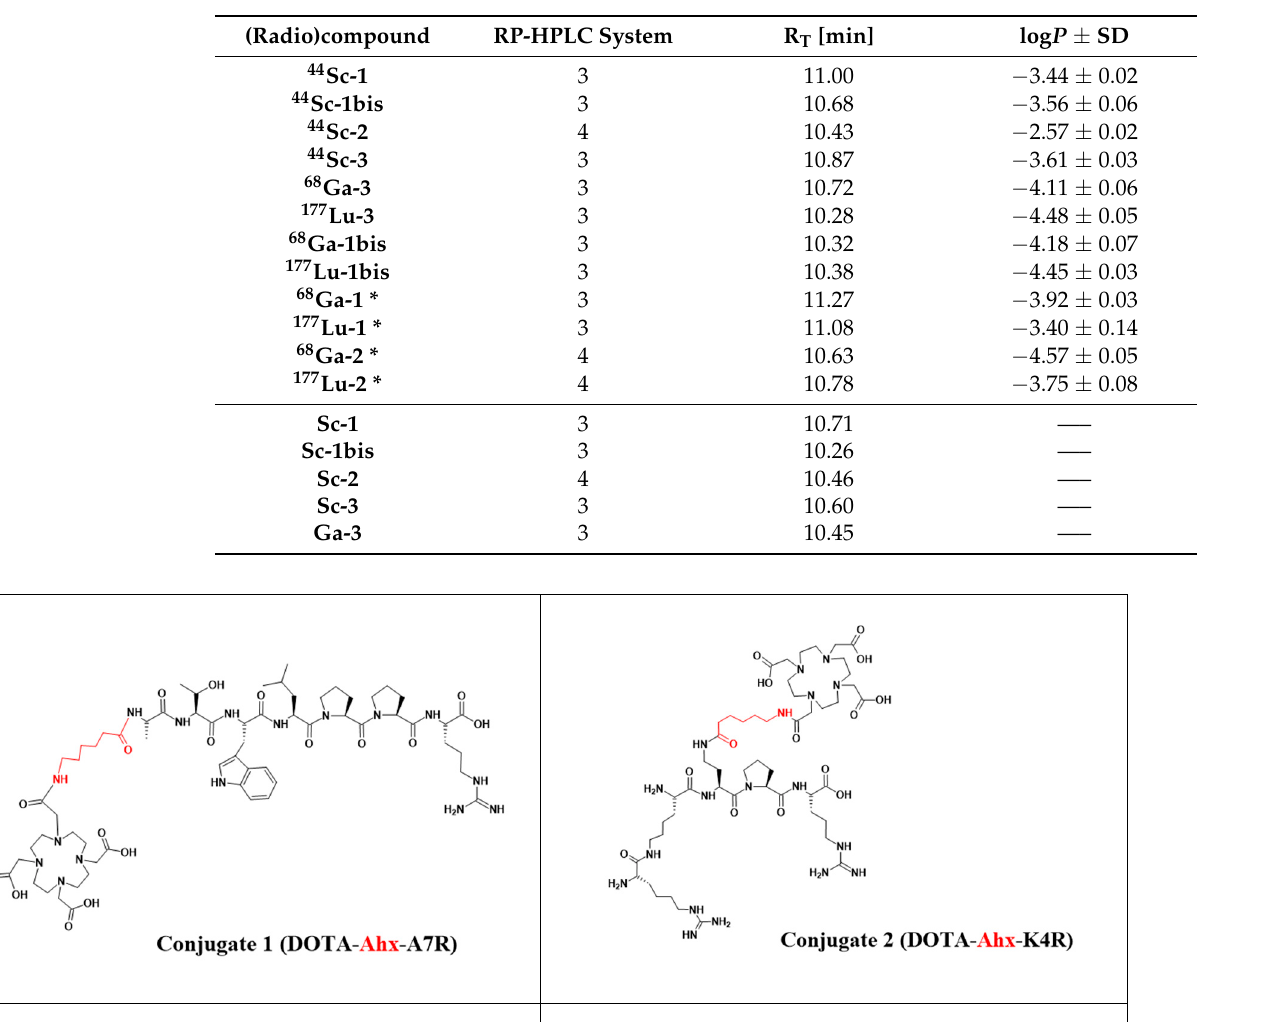
Table 1. R T and logP (presented as the mean ± SD, n = 3) parameters determined for (ra- dio)compounds tested in the present work. * radioconjugates synthesized and tested in [41].